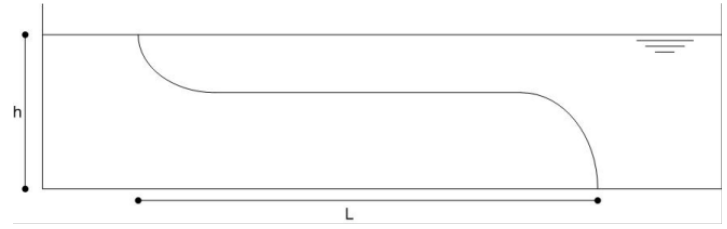
Figure 2. Drawing of a cross-section, with dense water flowing over light water and the definition of